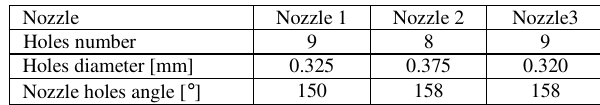
Fig. 1. The experimental setup schematic [11] Table 3. Fuel nozzles parameters